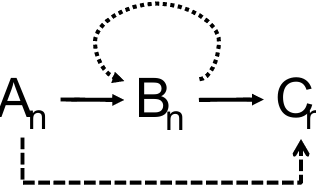
Figure 4. The emergent relations of transitivity (AC) and reflexivity (BB) observed in the Wide1 and Wide2 agents are shown in dashed arrows. The LS trained relations (AB, BC) are shown in solid